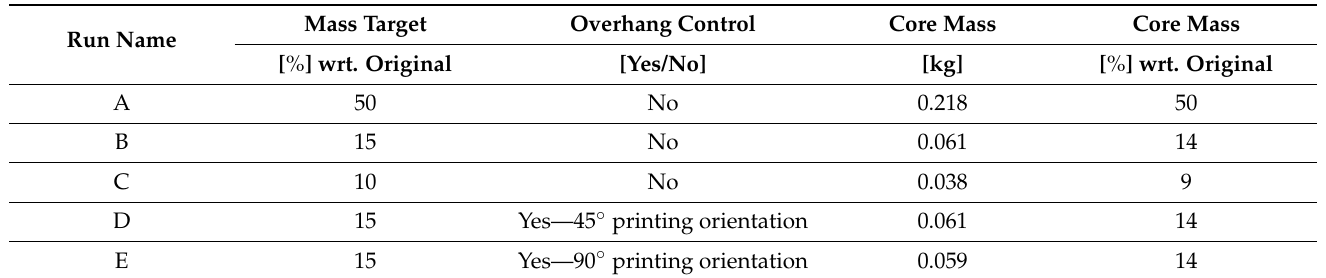
Table 4. Optimization